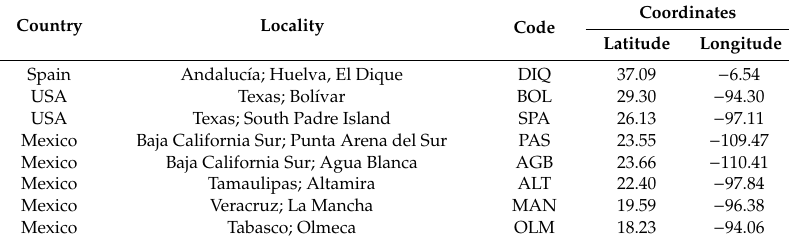
Table 1. Sampling localities of eight populations of Oenothera drummondii